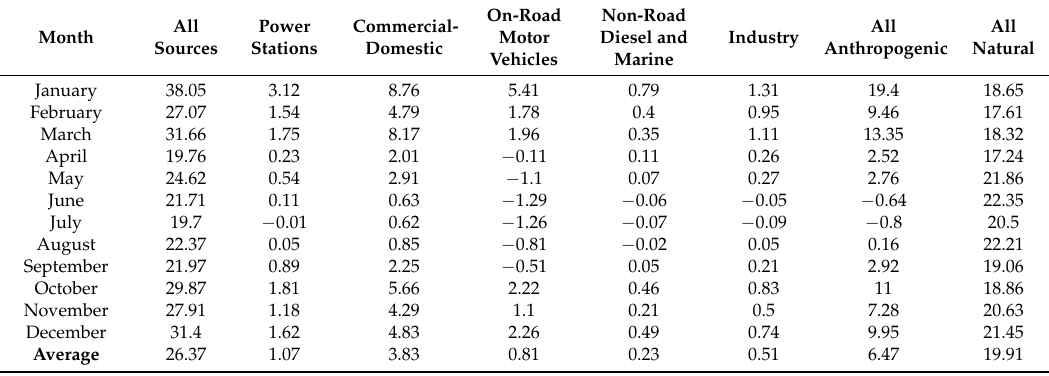
Table A2. Monthly average of daily maximum 1-hour predicted ozone concentration (ppb) in the Sydney south west region for different months in 2008 under various emission scenarios.